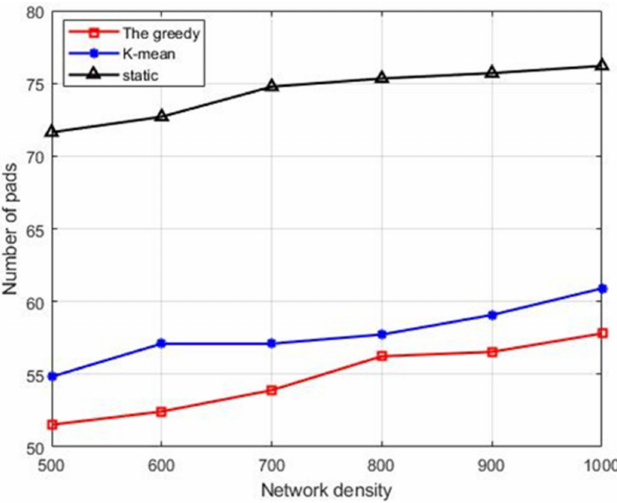
Figure 9. Comparison of the number of pads for diverse network densities.